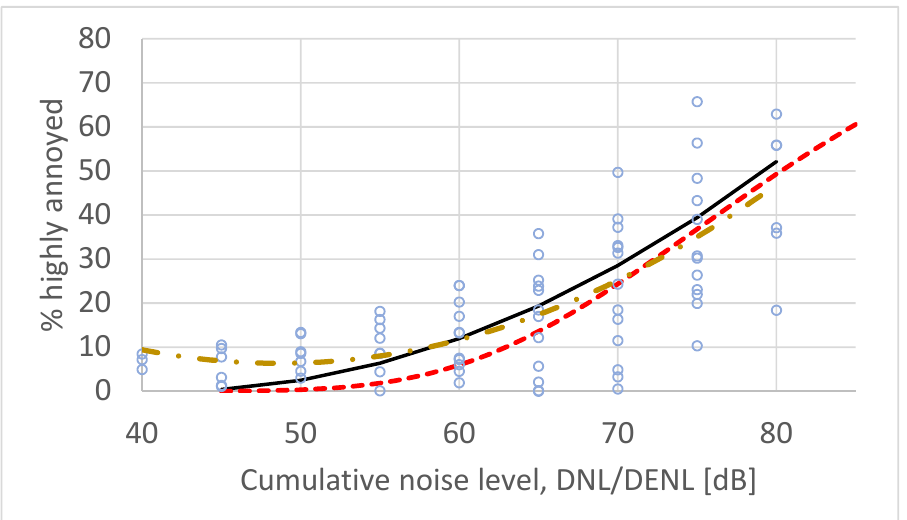
Figure 4. Set of calculated paired exposure/annoyance data from 18 post ‐ 2000 surveys on road traffic